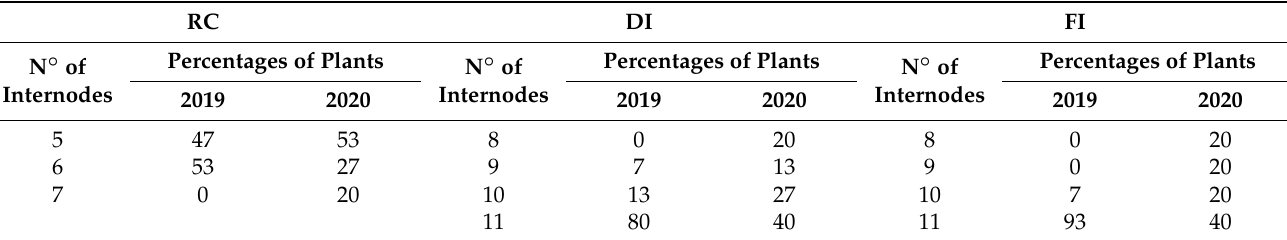
Table 3. Percentage of plants recorded to have a certain number of internodes.